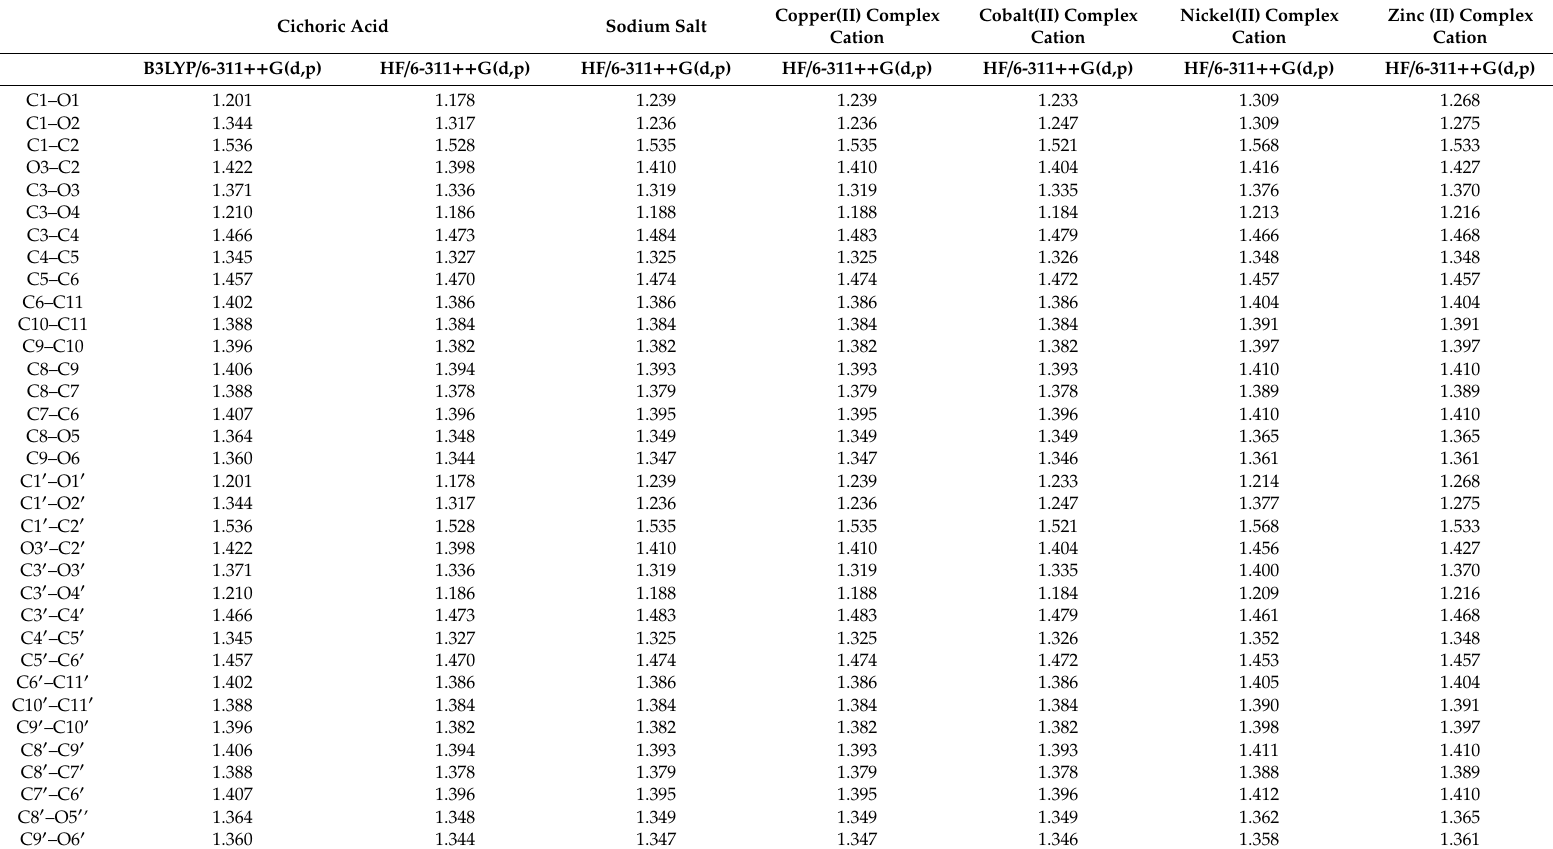
Table 3. Bond lengths for cichoric acid, sodium salt and cation (2 + ) complex of Cu(II), Co(II), Ni(II),